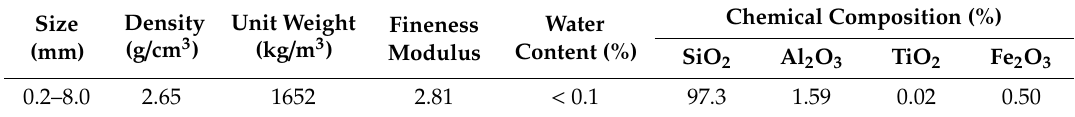
Table 6. Physical and chemical properties of siliceous